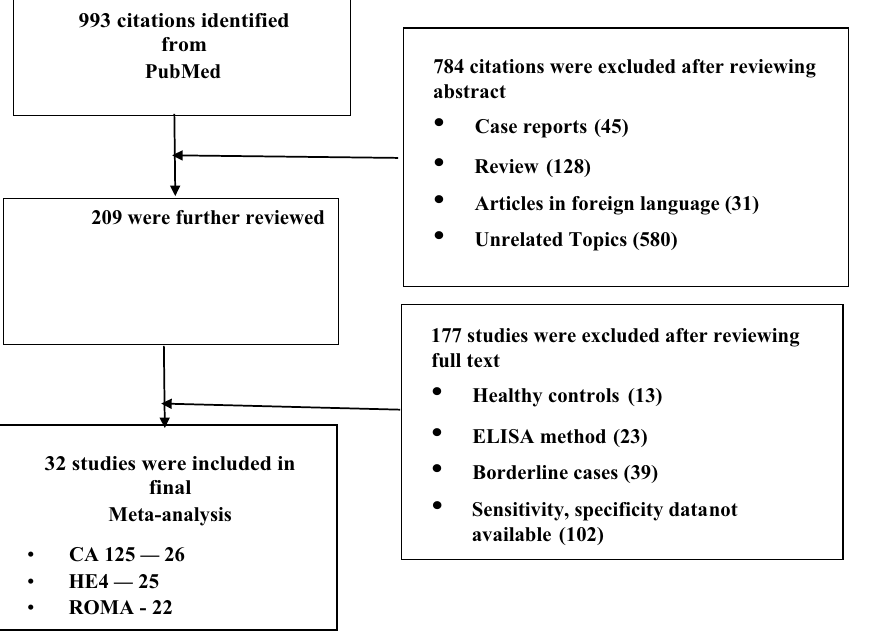
Figure 1. PRISMA Flow-diagram.